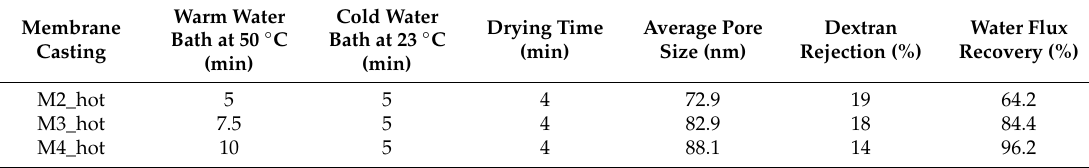
Table 1. Details of heat treatments for recovery of the hydrogel mold in patterned membrane. Membrane